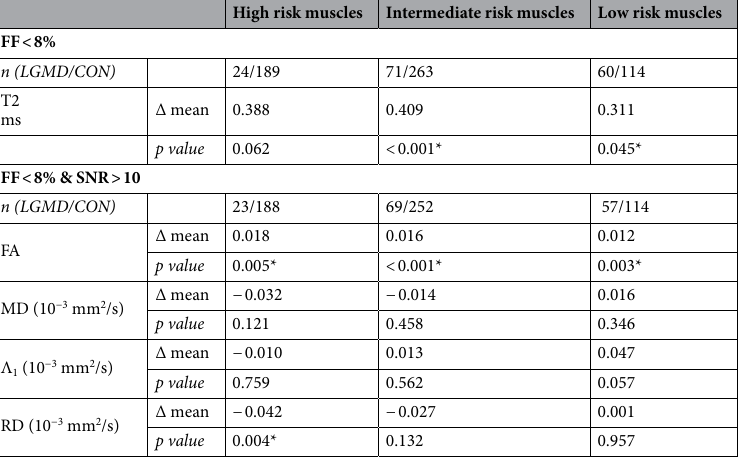
Table 2. Mean differences and p-values for two-sided t-tests for independent samples between patients and controls for the different muscle groups. Significant results are marked with an *. p < 0.05 was defined as statistically significant.